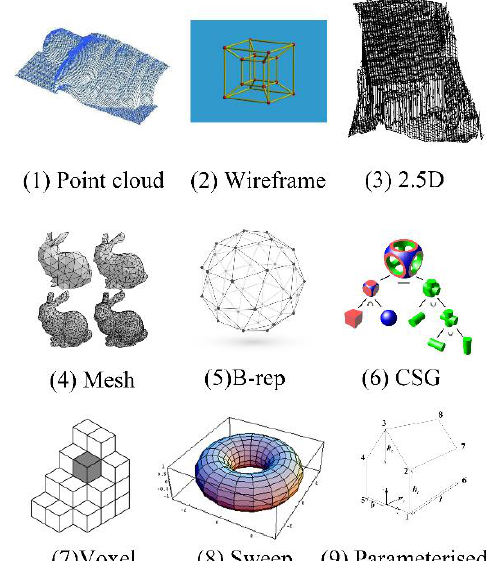
Figure 2. Examples of geometric modelling methods (adapted from Koeva